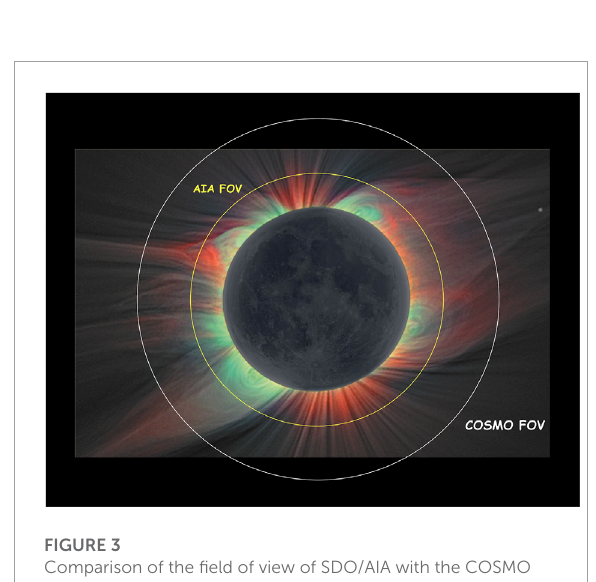
FIGURE 3 Comparison of the field of view of SDO/AIA with the COSMO one. Background eclipse image shows Fe XI (red) and Fe XIV (green) superimposed intensities from the 1 August 2008 eclipse (courtesy of Prof. S. R.